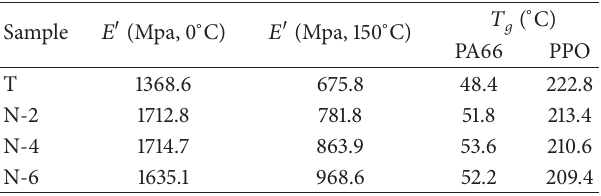
Table 2: Thermal data of PPO/PA66 blend and nanocomposites.